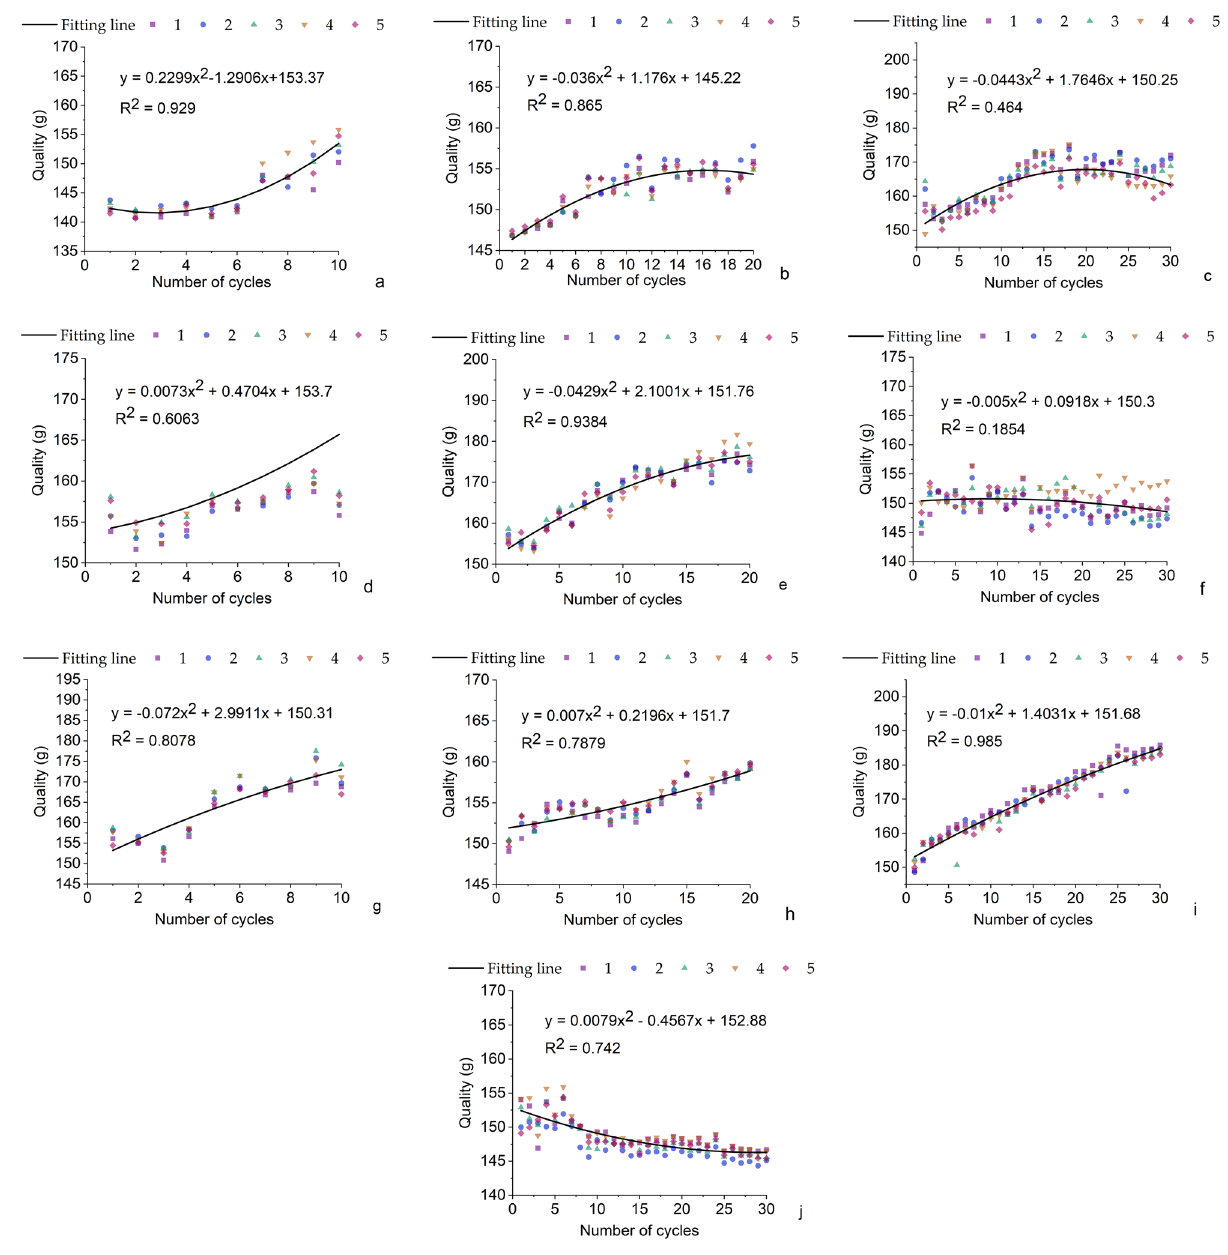
Figure 2. Mass change of each soil column ( a ) Experimental group 1; ( b ) Experimental group 2; ( c ) Experimental group 3; ( d ) Experimental group 4; ( e ) Experimental group 5; ( f ) Experimental group 6; ( g ) Experimental group 7; ( h ) Experimental group 8; ( i ) Experimental group 9; ( j ) Experimental group